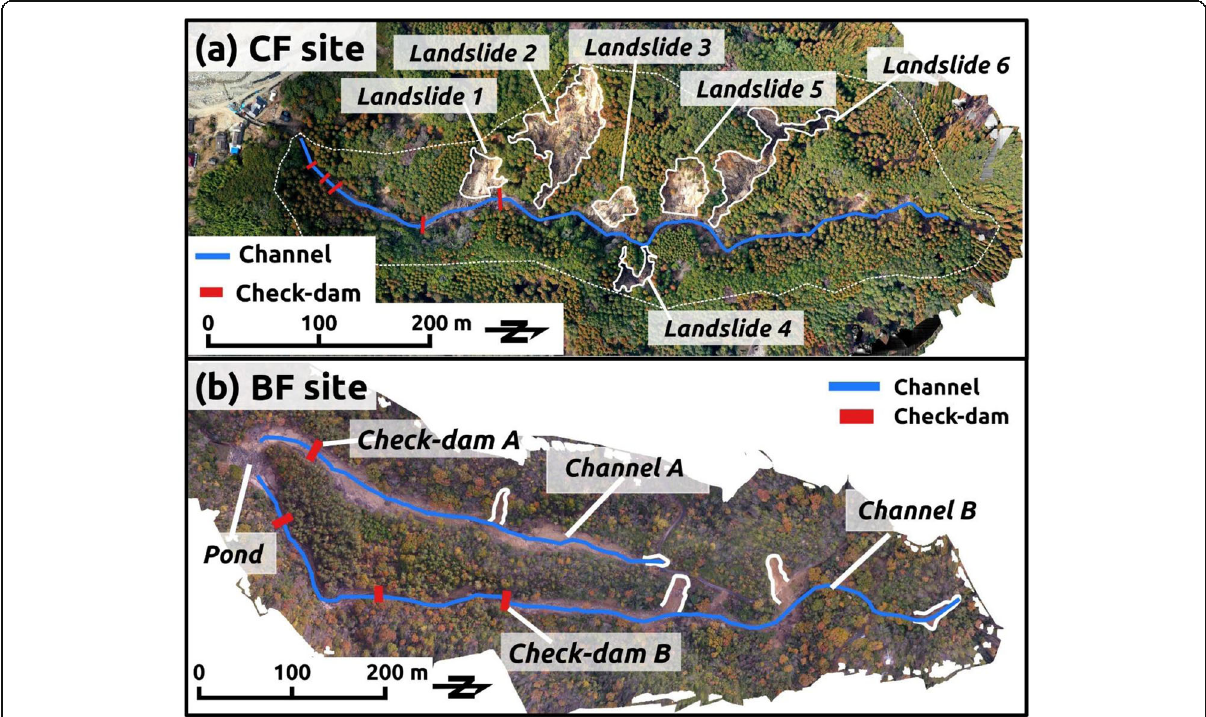
Fig. 2 Orthophoto of the study sites: a the coniferous forest (CF) site and b the broadleaf forest (BF) site. The right side indicates the upper part of the channel (i.e., the streams descend from north to south). The white solid lines indicate the landslide scars. The white dotted line in panel a indicates the boundary of